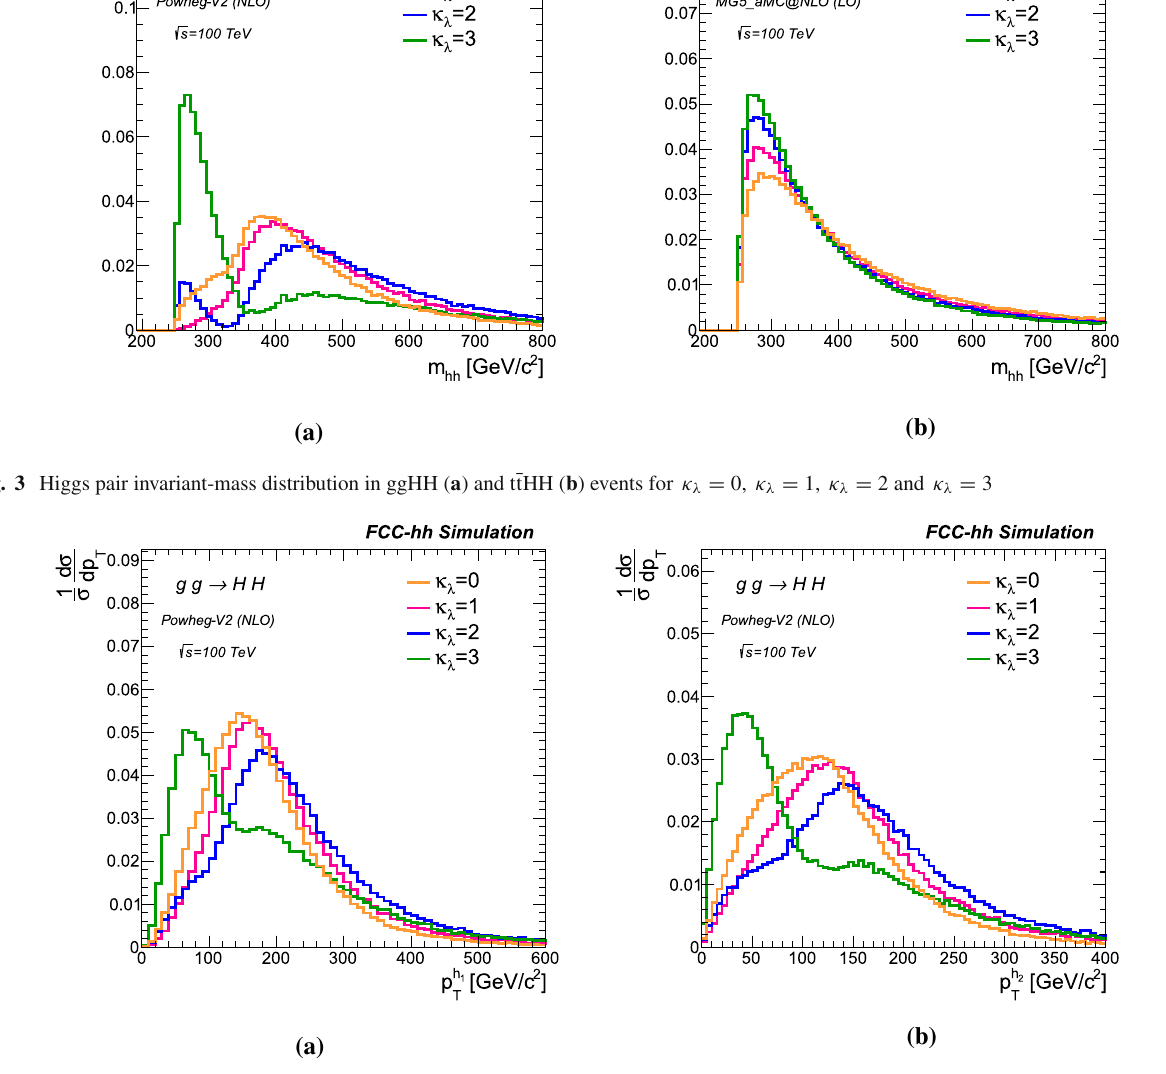
Fig. 4 Transverse momentum spectra of the leading ( a ) and sub-leading ( b ) Higgs boson in ggHH events for κ λ = 0, κ λ = 1, κ λ = 2 and κ λ =